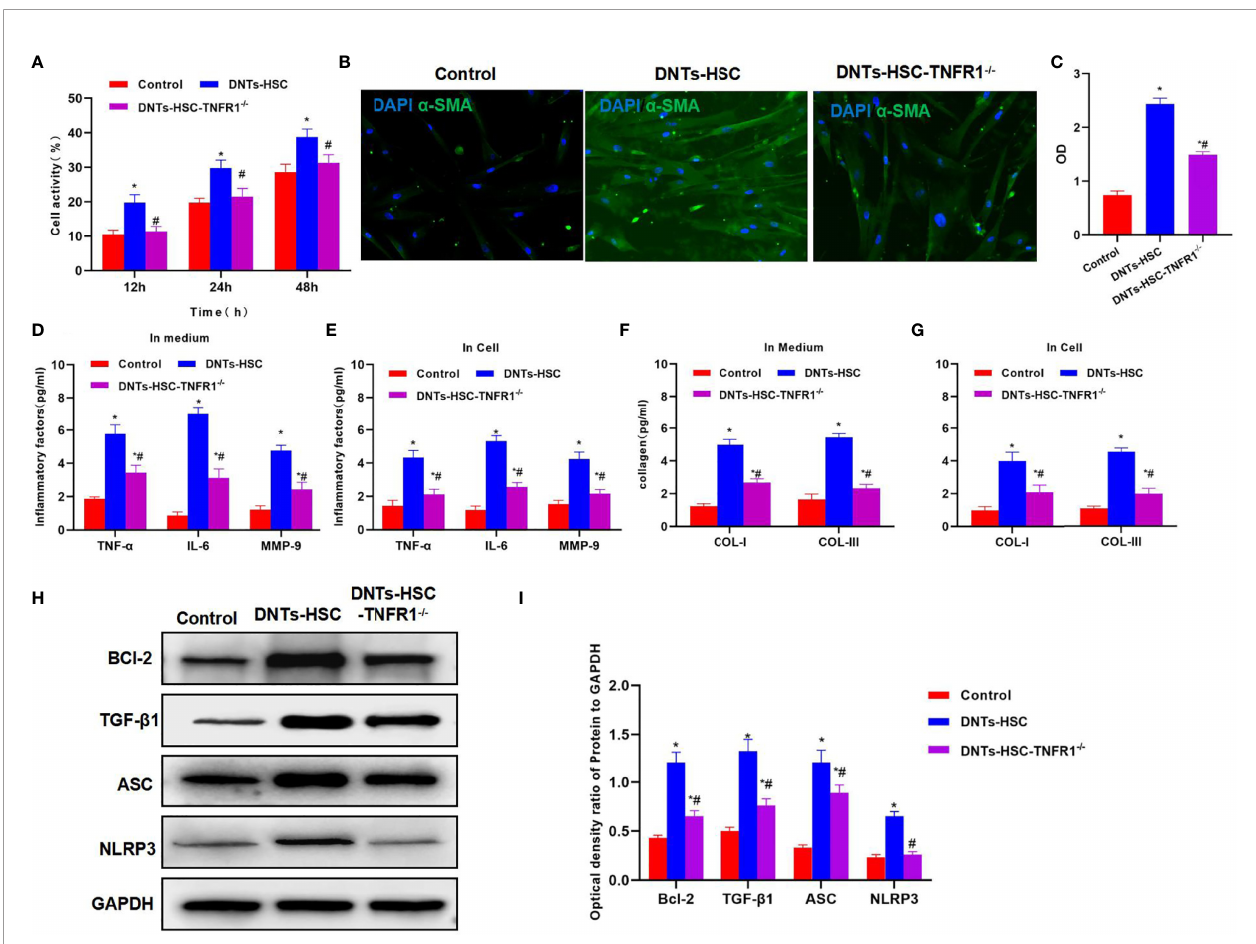
FIGURE 4 | Effect ofDNTs on HSC activation after TNFR1 knockdown(HSC- TNFR1 − / − ). (A) After TNFR1 knockdown,DNTs had weakened ability to induce the upregulation ofHSC viability.Cell viability signi fi cantly decreased compared with DNT-HSC but was stillhigher than thatof the control group.*p< 0.05 comparedwith control group, # p < 0.05 compared with DNT-HSC group. (B, C) After TNFR1 knockdown,the fl uorescence intensity ofHSC activation marker a -SMAsigni fi cantly decreased.*p < 0.05 compared with control group, # p < 0.05 compared with DNT-HSC group. (D, E) Results of in fl ammatory factor expression demonstrated that the in fl ammatory factor levelssigni fi cantlydecreased in HSC- TNFR1 − / − , lower than those of DNT-HSC group. *p < 0.05 compared with control group, # p < 0.05 compared with DNT-HSC group. (F, G) After TNFR1 knockdown, DNTs had reducedability to inducecollagen expression in HSCs. The expression levels of COL-I and COL-III inHSC- TNFR1 − / − markedly decreased,lower than those inDNT-HSC. *p < 0.05 compared with control group, # p < 0.05 compared with DNT-HSC group. (H, I) After TNFR1 knockdown, DNTs had reduced ability to induce TNFR1 and Bcl-2 expression,and the protein levels were markedly lower than those of DNT-HSC group. *p < 0.05 compared with control group, # p < 0.05 compared with DNT-HSC group. DNTs, double-negative T cells; HSC, hepaticstellate